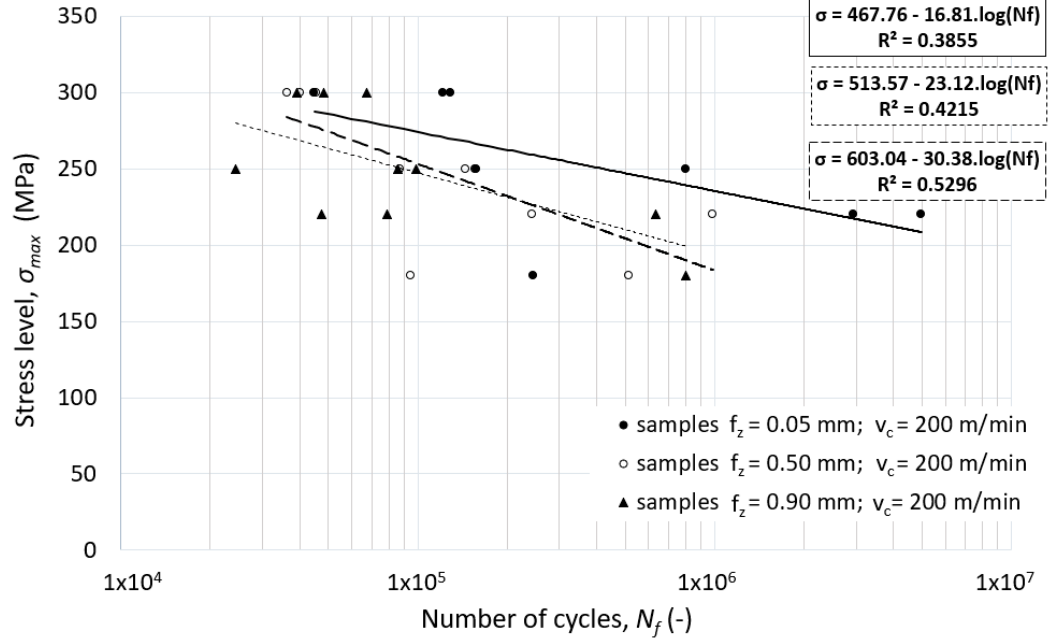
Figure 17. The effect of the feed speed (feed per tooth) on the fatigue life of alloy 7475-T7351—flat un-notched specimen ( v c = 200 m.min − 1 ).